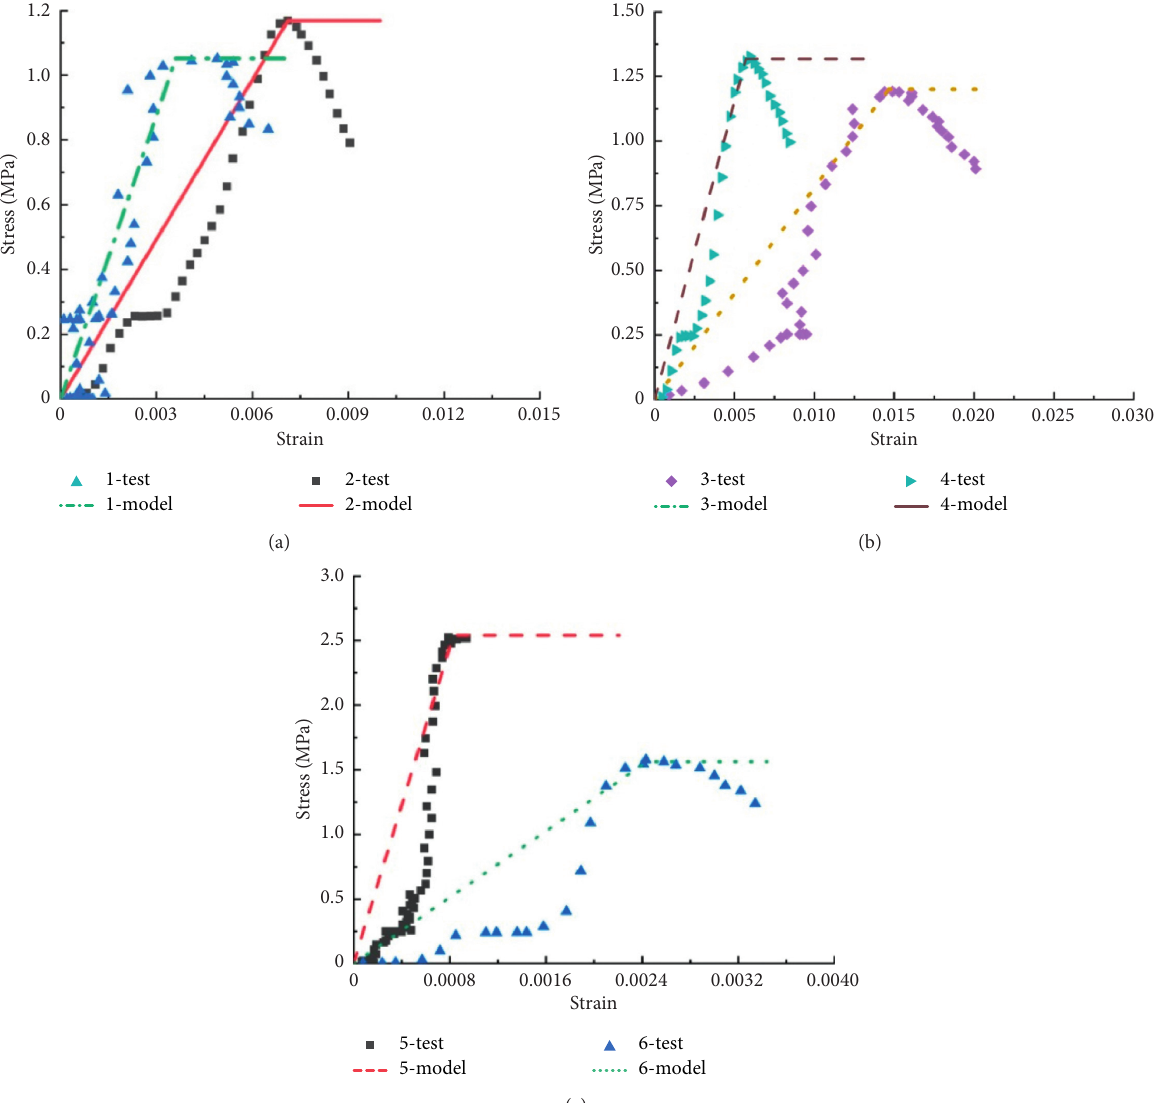
Figure 10: Comparison of stress-strain relationship of CPB between model simulation and experiment